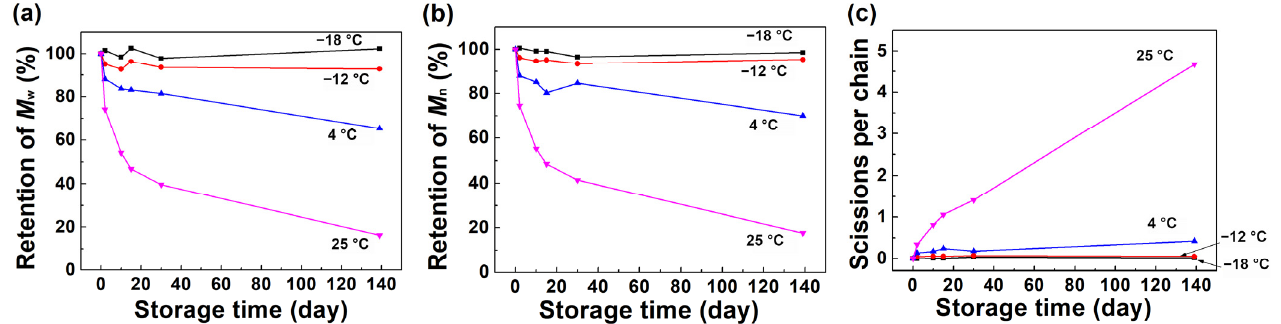
Figure 6. Retention of ( a ) M w , ( b ) M n , and ( c ) scissions per chain of (6FDA-DMB) PAA in a concen- trated solution stored at − 18 °C, − 12 °C, 4 °C, and 25 °C for different times.